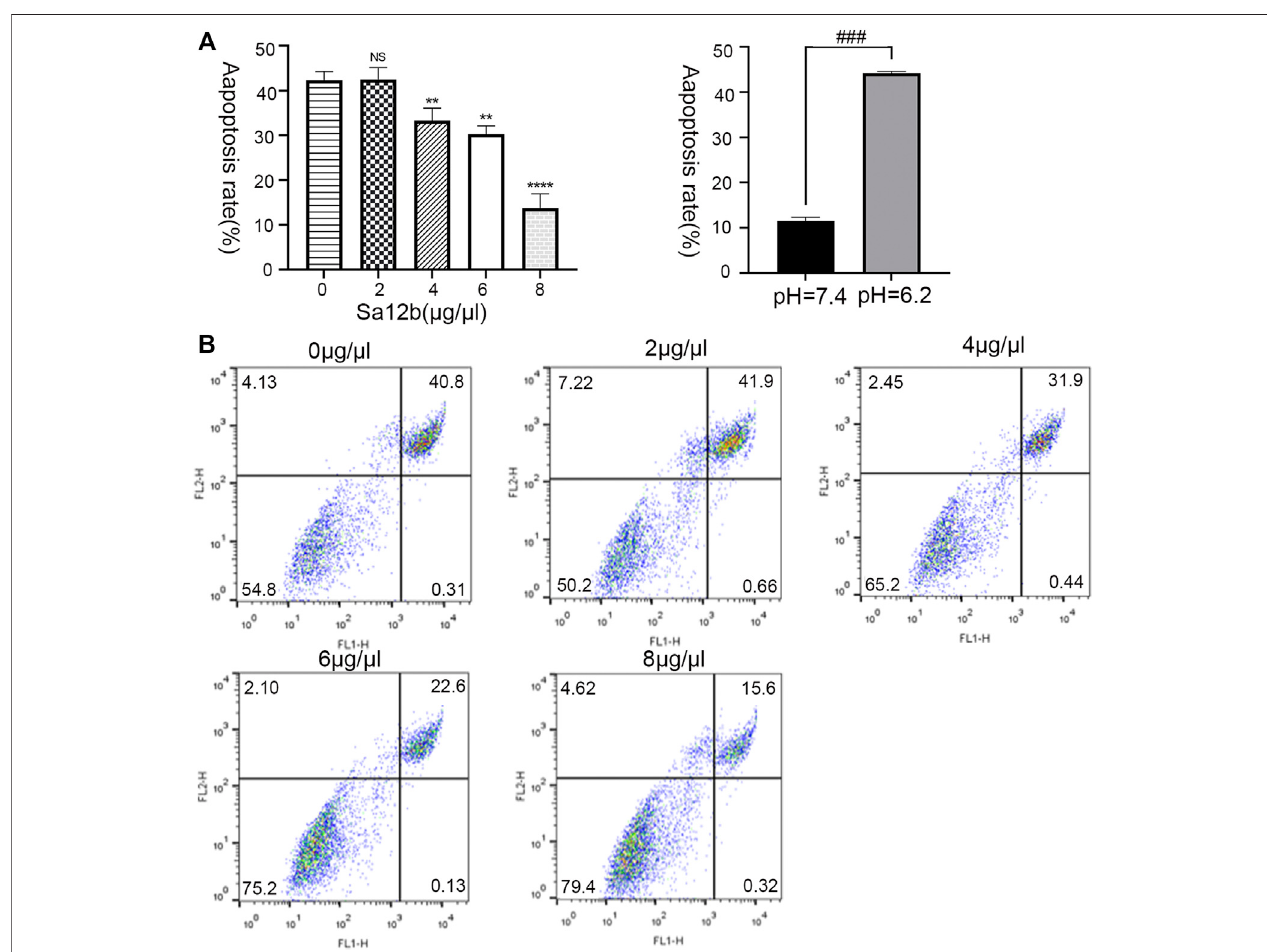
FIGURE4| Sa12breducedtheapoptosisrateofNP-MSCsinasevereacidicenvironment. (A) Theapoptotic rateofNP-MSCsinanacidicenvironment( pH =6.2) was signi fi cantly higher than normal ( pH = 7.4). When different concentrations of Sa12b (0, 2, 4, 6, and 8 μ g/ μ l) were added, the apoptotic rate of human degenerated NP-MSCswassigni fi cantlyreduced.**indicates p < 0.01;****indicates p < 0.0001;NSindicatesnostatisticalsigni fi cancewhenthecontrolgroup( Sa12b =0 μ g/ μ l)was comparedwiththeothergroups; ### indicates p < 0.001whenthecontrolgroup( pH =7.4)wascompared withthetreatment group( pH =6.2). (B) Flowcytometry of NP-MSCs treated with different concentrations of Sa12b. The upper right corner indicates the proportion of late apoptosis.